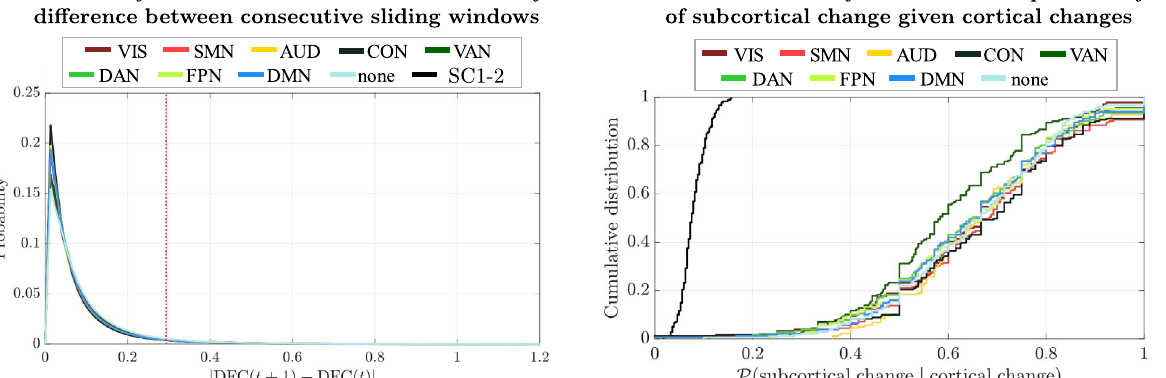
network. Right) Cumulative density function of the conditioned probability of sub- cortical connectivity reorganization, given a cortical connectivity reorganization. Each colored line relates to a different cortical network. The black line shows the cumulative density function under the null hypothesis of independence between cortical and subcortical changes. Source data are provided as a Source data fi